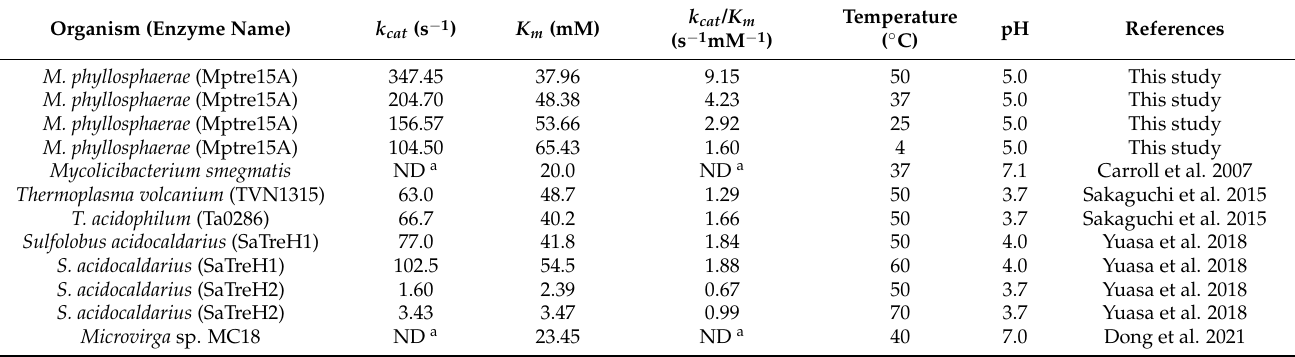
Table 4. Kinetic parameters of various GH15 family trehalases toward substrate